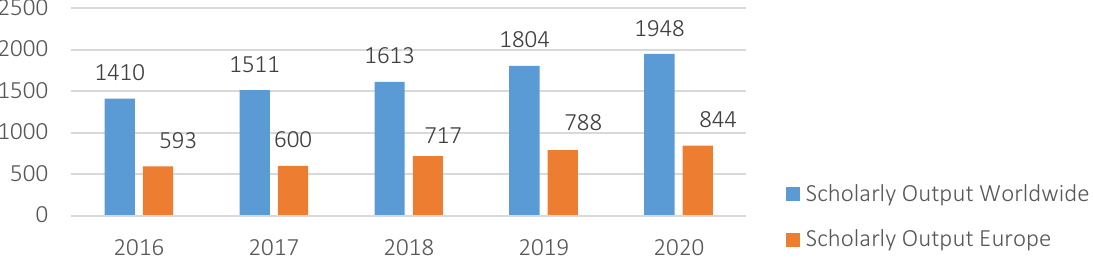
Figure 1. Number of publications in the Scopus database under the research